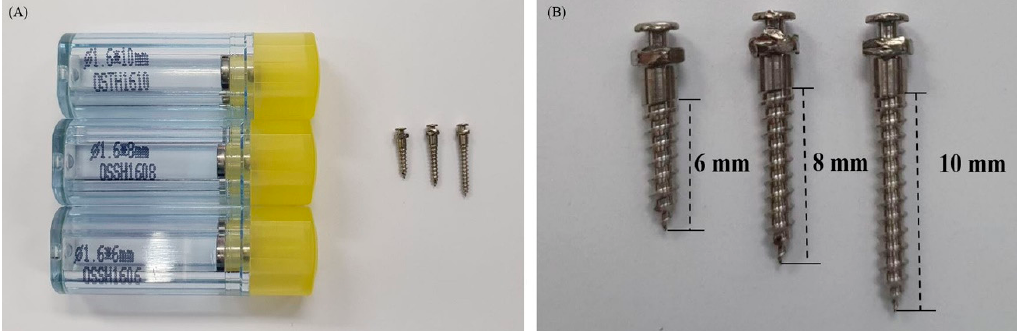
Figure 2. Orthodontic anchor screws used in the study. ( A ) Actual size of OAS; ( B ) Thread length of OAS.